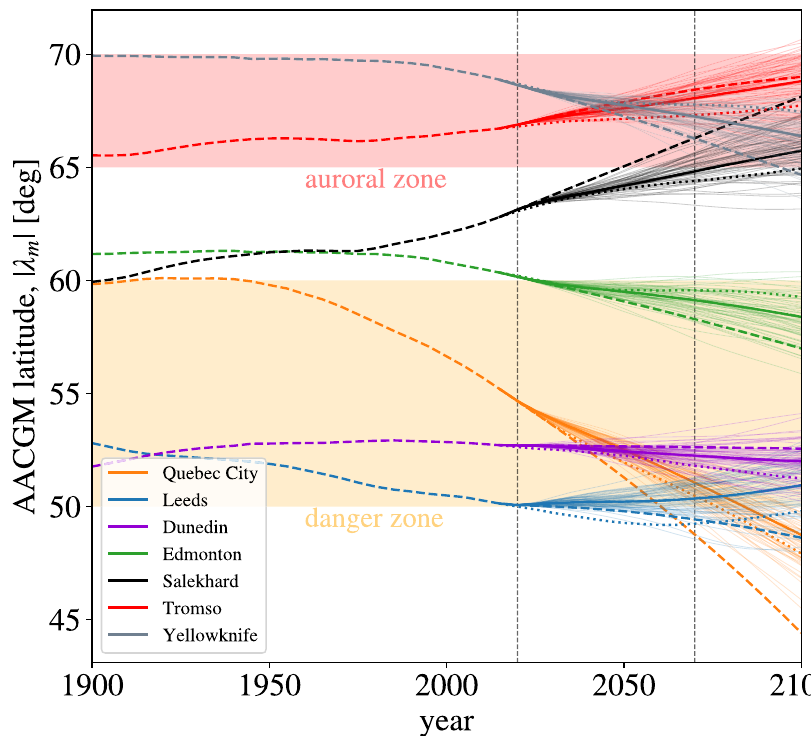
Figure 3. Evolution of the absolute value of AACGM latitude for selected cities. The selected locations are also reported in Fig. 1. The dashed vertical lines indicate the 2020 and the 2070 epochs. The shaded areas indicate the limits of the auroral and ‘danger’ zones ( 65 ◦ -to- 70 ◦ and 50 ◦ -to- 60 ◦ AACGM latitudes, respectively). The IGRF-13 model (up to 2020) and the IGRF forecast (after 2020) are represented by the dashed lines. The mean MPG forecast and ensemble members are represented by continuous thick and thin lines, respectively. The IPGP forecast is represented by dotted